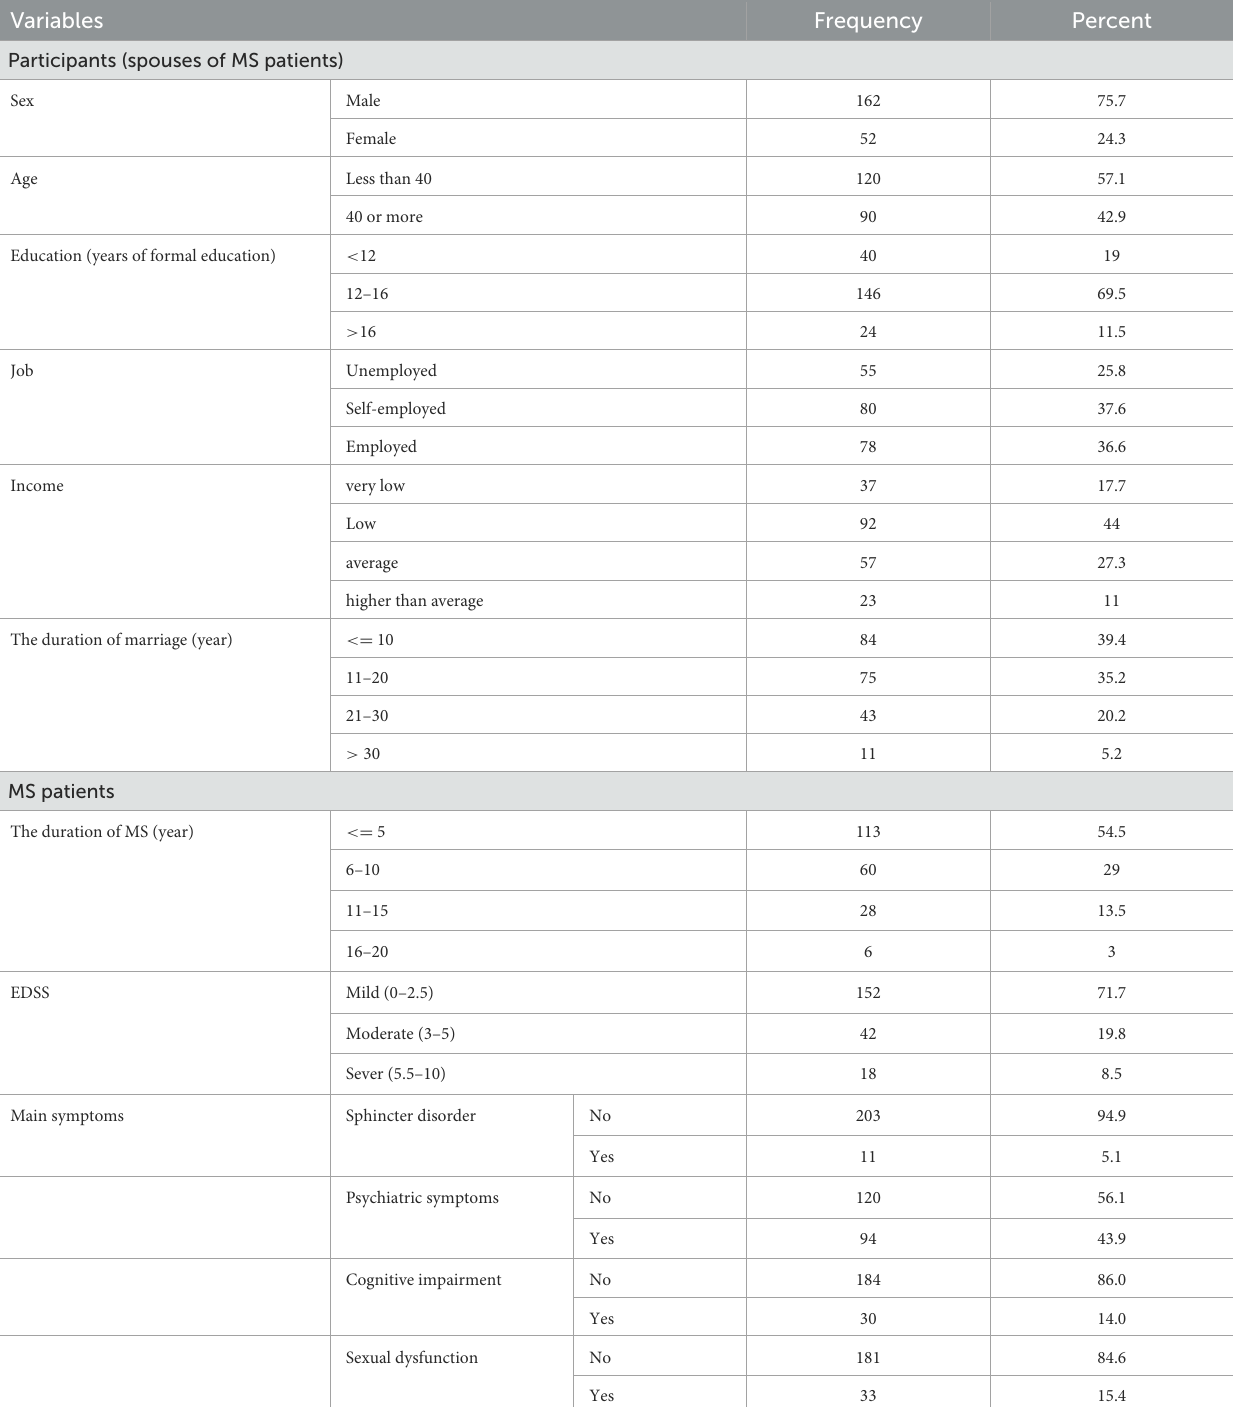
TABLE 1 Demographic variables of the spouses of multiple sclerosis (MS) patients and the clinical details of MS patients.